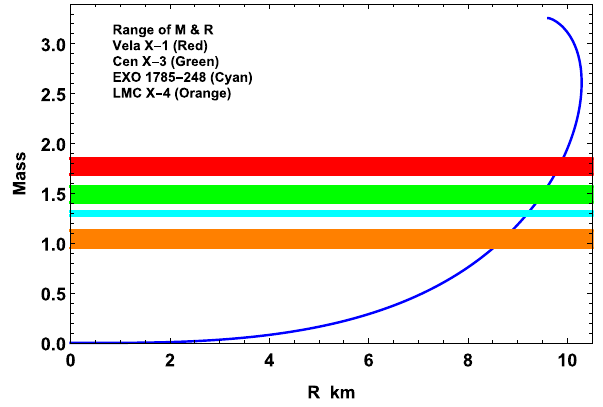
Fig. 12 M – R diagram and ranges of mass corresponding to numerical values of constants given in Table 2 for four well-known compact